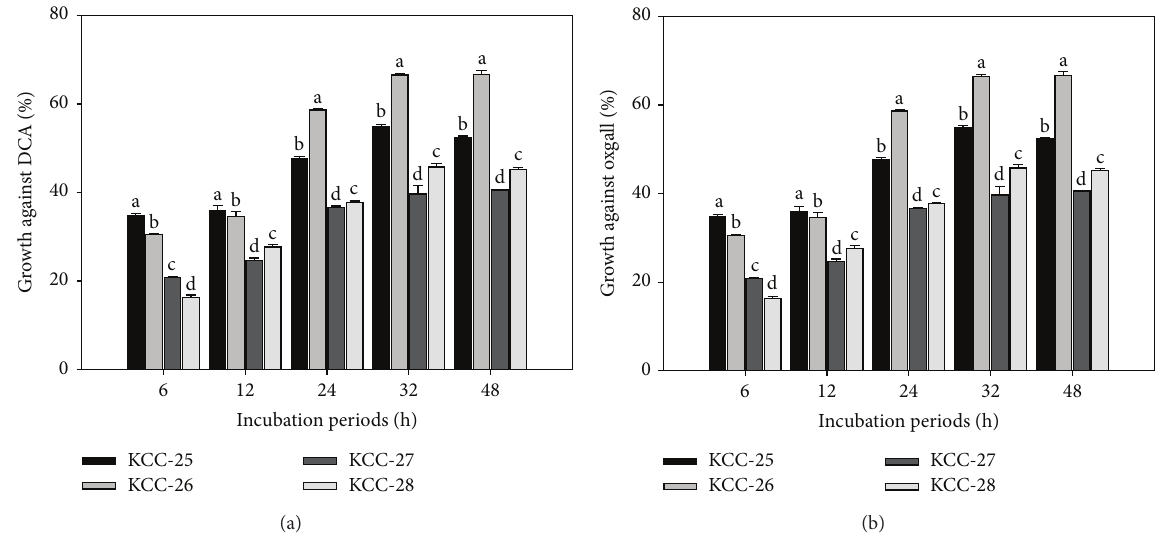
Figure 4: Bile salt tolerant properties of L. plantarum . (a) KCC-25, KCC-26, KCC-27, and KCC-28 growth in sodium deoxycholate (DCA). (b) KCC-25, KCC-26, KCC-27, and KCC-28 growth in oxgall. abcd Different letters within treatment represent the significant difference ( 𝑝 < 0.05